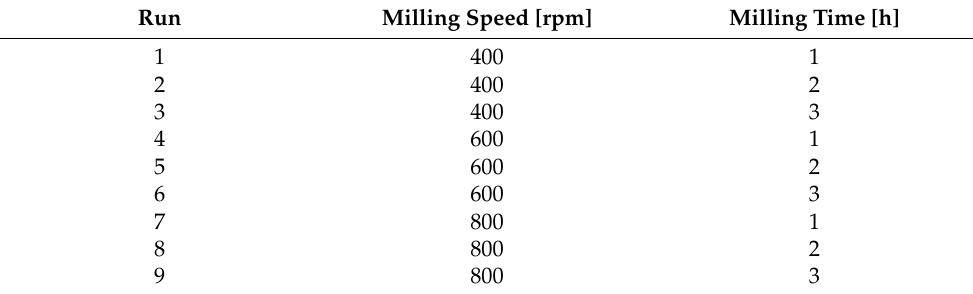
Table 1. Ball-milling parameter combinations investigated.